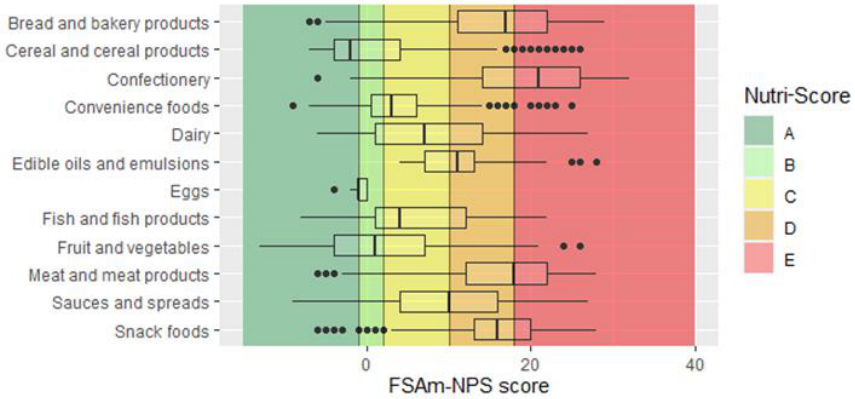
Figure 2. Distribution of FSAm-NPS score for main food categories ( n = 15,822). Vertical lines represent borders of five Nutri-Score grades from A to E. Left boundary of the box represents 25th percentile, line in the box is median, and right boundary represents 75th percentile. Error bars represent lower limit (25th percentile − 1.5 × (interquartile range)) and upper limit (75th percentile + 1.5 × (interquartile range)). Black circles are individual outliers.